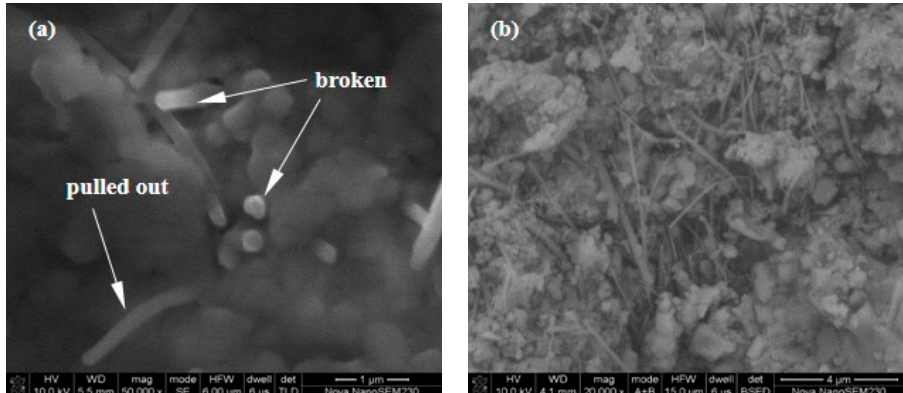
Figure 9. Microstructure and morphology of CNFC ( a ) CNFs pull-out and fracture; ( b ) CNFs aggregation and winding.